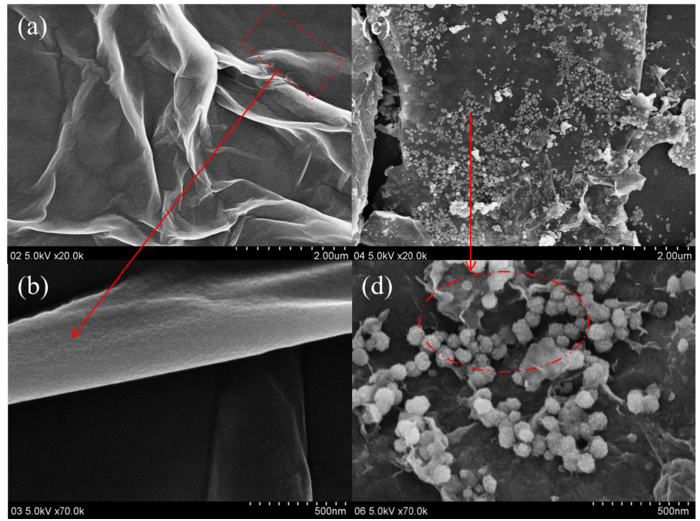
Figure 3. Visualization of the effect of the grafting of the ferrites and ferrite structure using field emission scanning electron microscopy (FESEM) for ( a ) unmodified GO × 20,000, ( b ) unmodified GO × 70,000 and ( c ) modified GO@Fe × 20,000 and ( d ) modified GO@Fe × 70,000. 3 O 4 3 O 4